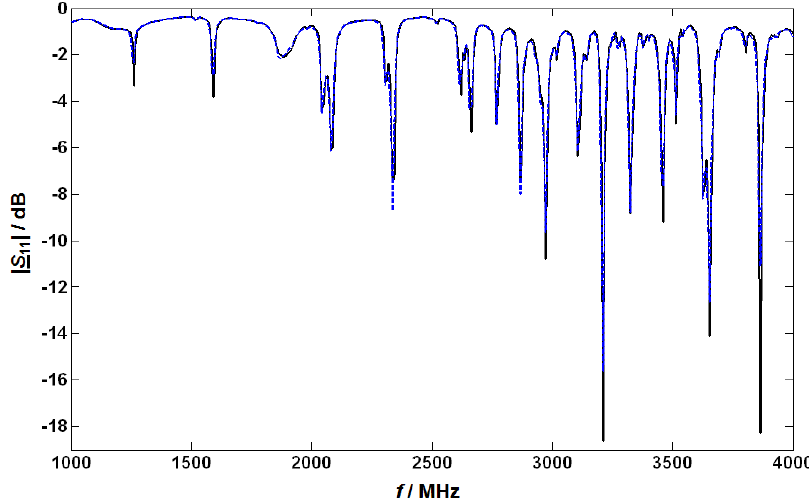
Figure 2. Negative return loss, or logarithmic absolute magnitude of the reflection coefficient | S |, as function of the frequency in the unloaded lean state (solid curve) and 11 the NO loaded state (dashed), both at 300 x